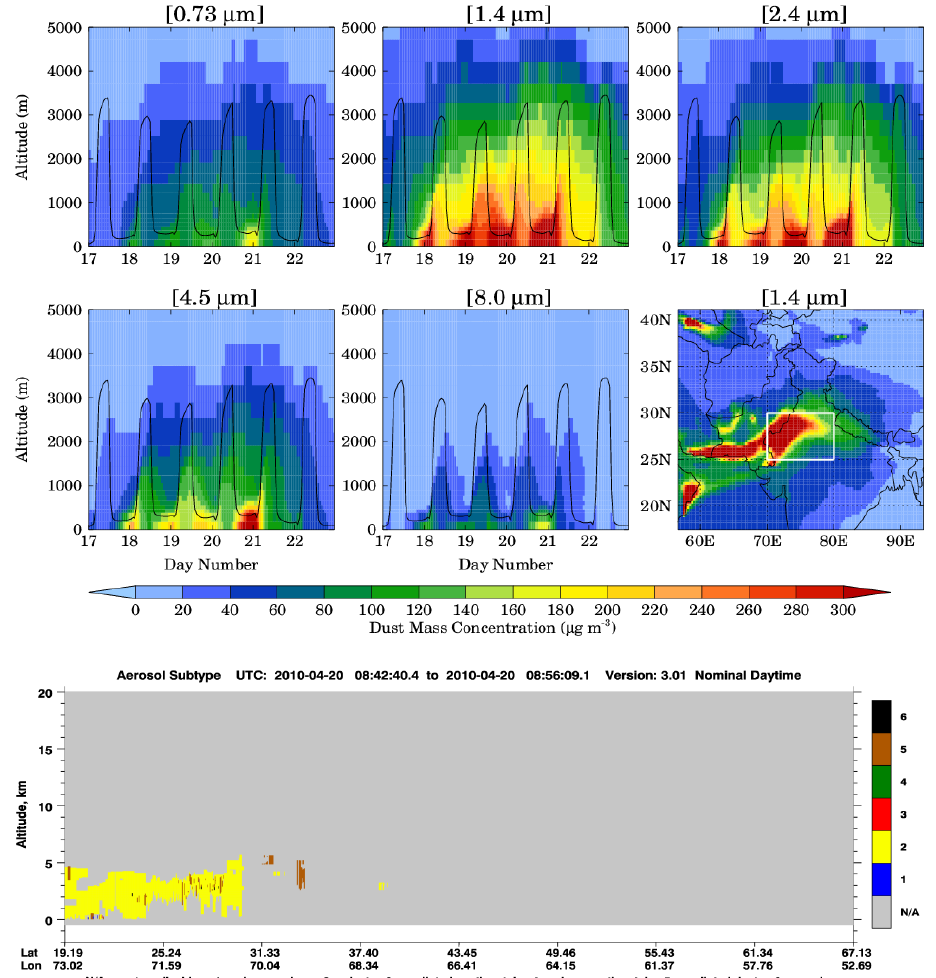
Fig. 6. Vertical distributions of mass concentration of dust particles with 0.73, 1.4, 2.4, 4.5 and 8.0µm effective radii during 17–22 April 2010. The black lines represent the temporal variations of average PBL height. The geographical region (70–80 ◦ E, 25–30 ◦ N) over which dust mass concentrations and PBL height are averaged is shown by white outlined box in the figure in rightmost middle panel, which also shows the spatial distributions of dust mass concentration at 1.4µm at the surface. The time–altitude image of aerosol subtypes retrieved by CALIPSO on 20 April 2010 (see track in Fig. 1b) is shown in bottom